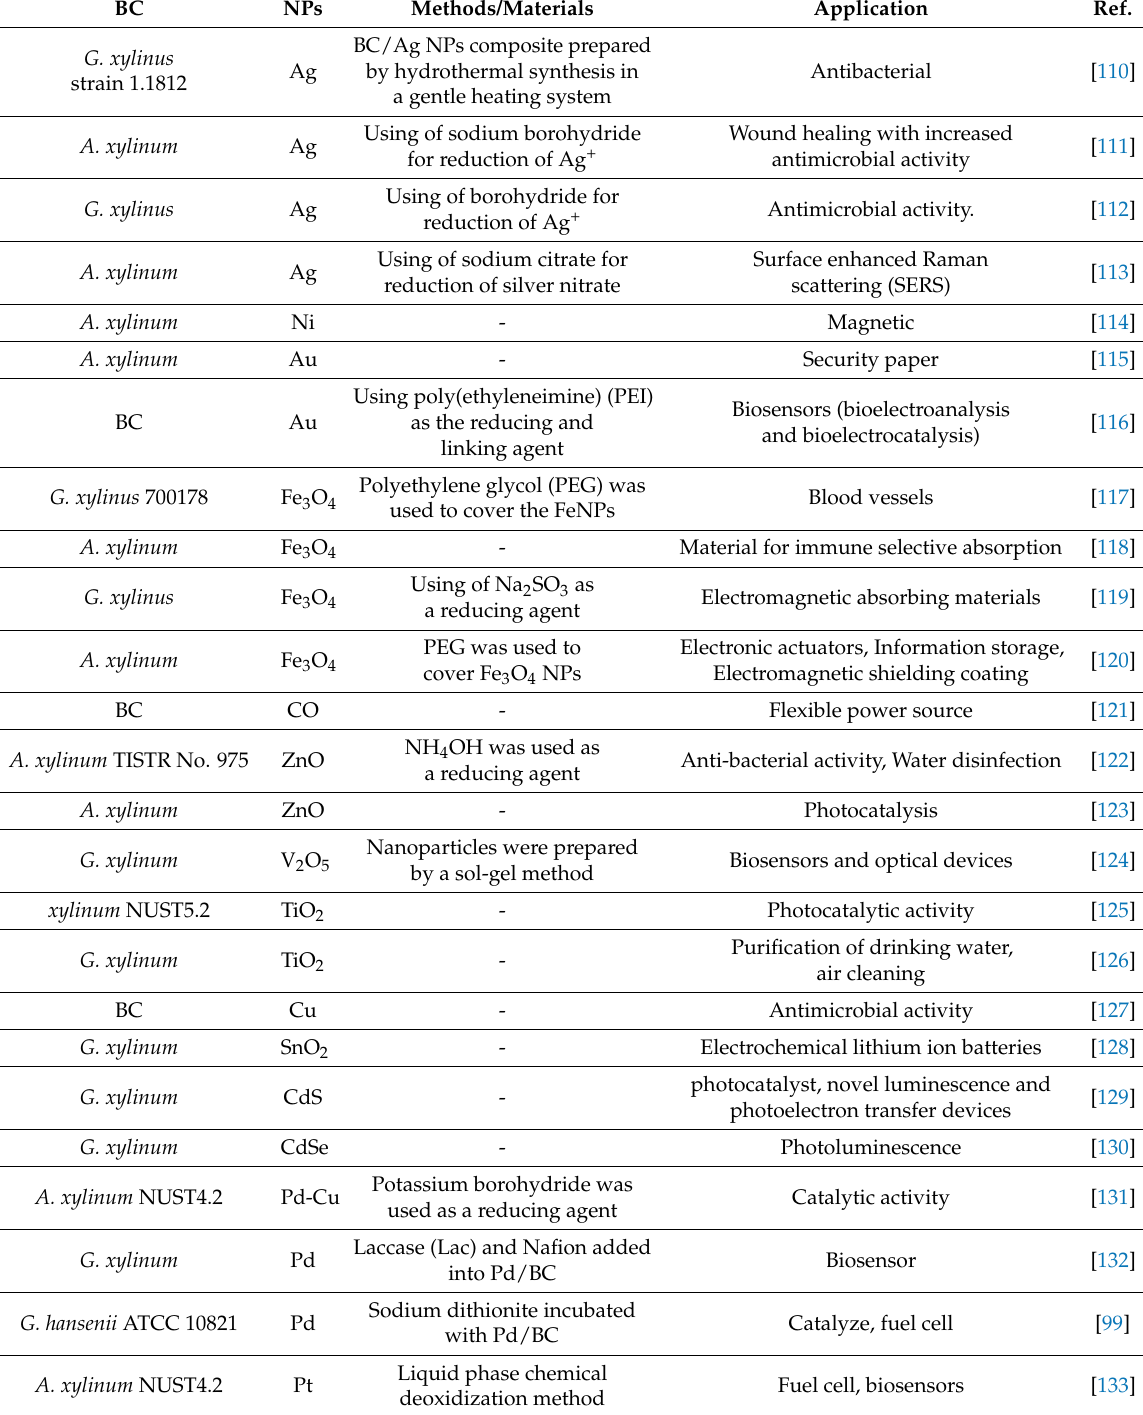
Table 1. BC/nanomaterial composites and their